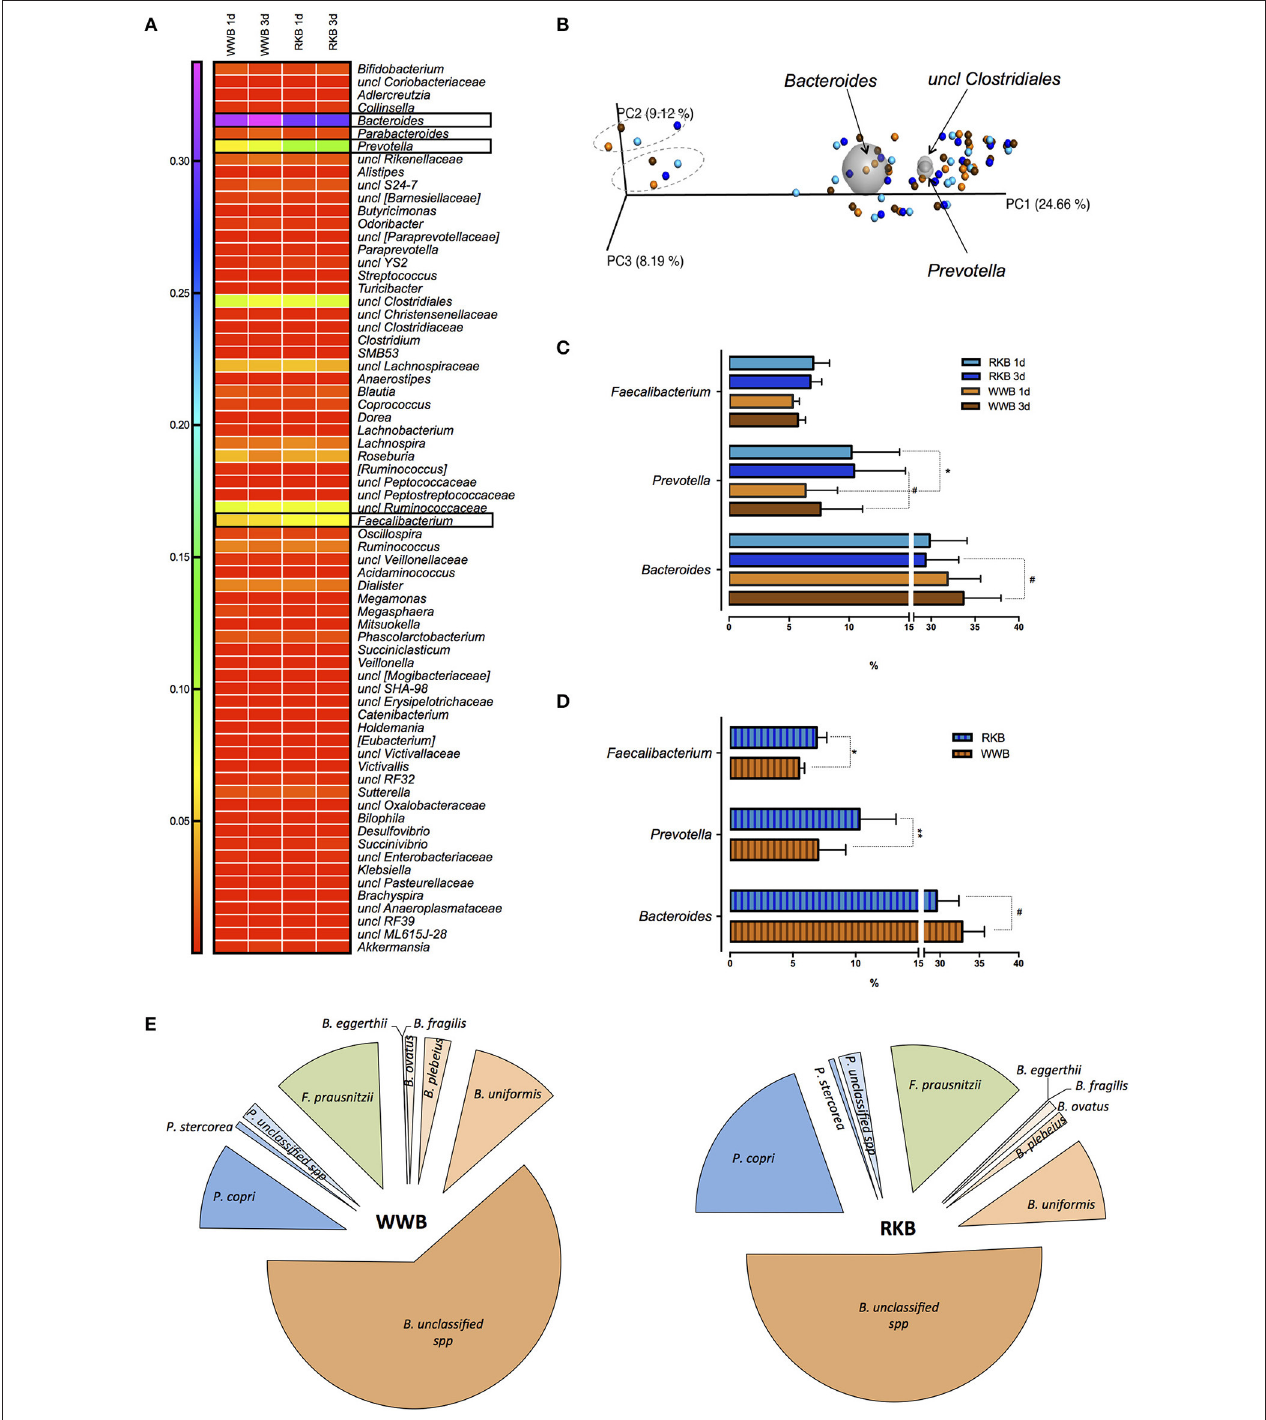
FIGURE 2 | The OTUs assignment to the genus level presented as a heat map per each test occasion after WWB and RKB product consumption during 1 or 3d period (A) ; PCoA plot showing distribution of bacterial community between the participants after consumption of RKB 1d (light blue circles), RKB 3d (blue circles), WWB 1d (orange circles) and WWB 3d (brown circles), while bi-plots (grey spheres) visualize the three taxa driving the differences in the cohort where outlier two persons are circled with dashed line (B) ; The most significant differences in bacterial genera between bread consumption for each test occasions included duration of the bread consumption (C) where RKB 1d ( n = 18), WWB 1d ( n = 18), RKB 3d ( n = 19), WWB 3d ( n = 19), and pooled result (D) from each type of bread (RKB vs. WWB, n = 37/per each bread) on genus level or (E) species level. * p < 0.05, ** p < 0.01, # p ≤ 0.08; RKB, rye kernel bread; WWB, white wheat bread; B.